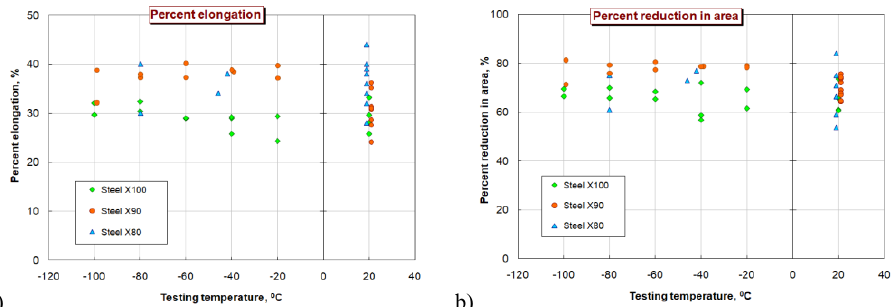
Fig. 3 . Comparison of ultimate deformation characteristics: percent elongation (a) and percent reduction in area (b).